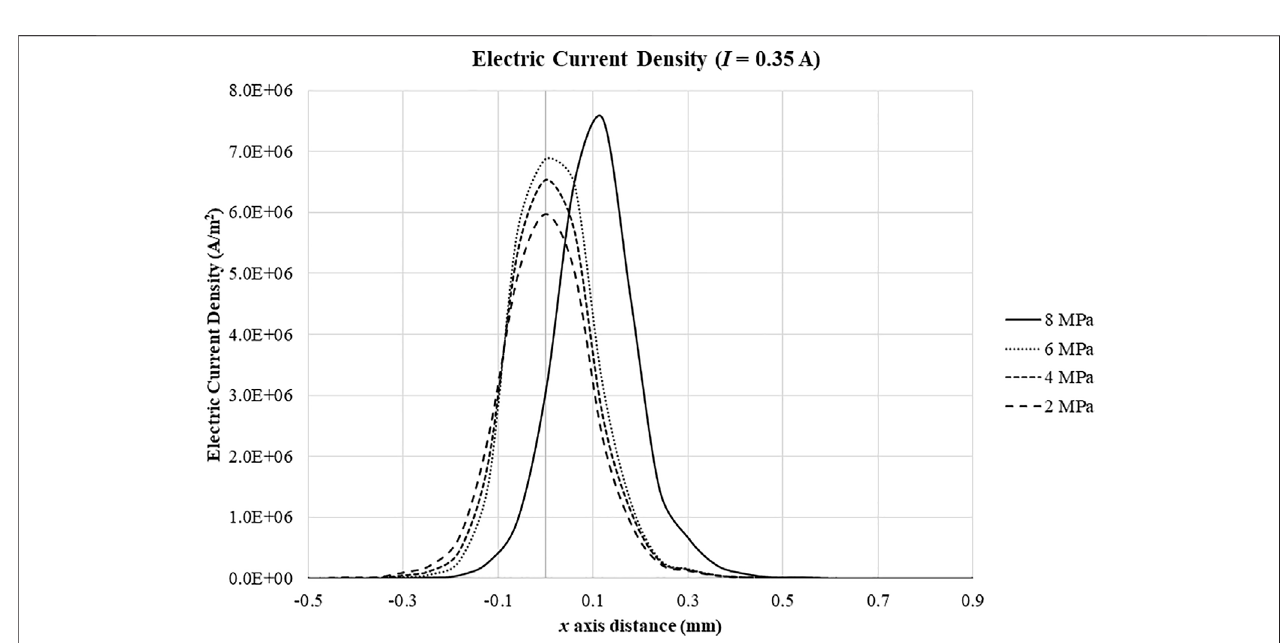
FIGURE 6 | Electric current density in the x axis direction at the center of the inter-electrode gap ( t (cid:2) 50 ms, I (cid:2) 0.35 A).